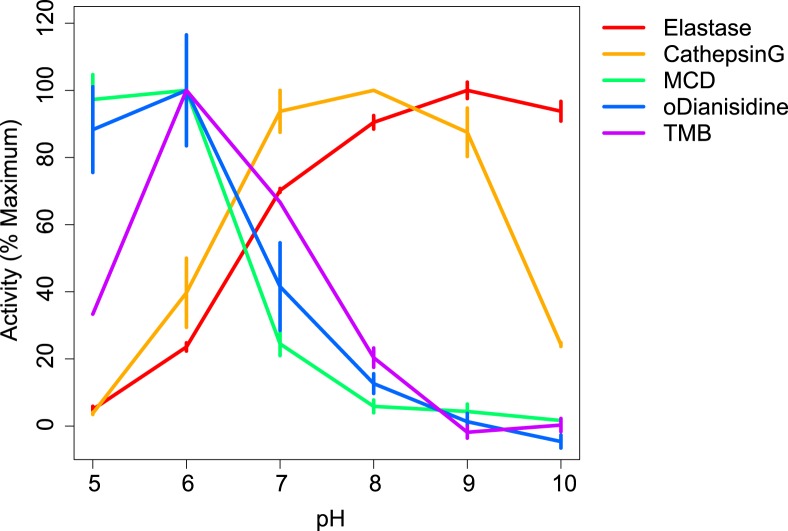
Effects of pH on enzymatic activity.The effect of variations in pH on peroxidatic and chlorinating activities of MPO and on the protease activities of cathepsin G and of elastase are shown. Results shown are the mean + SD of at least three separate assays and are expressed as a percentage of the maximal observed activity.